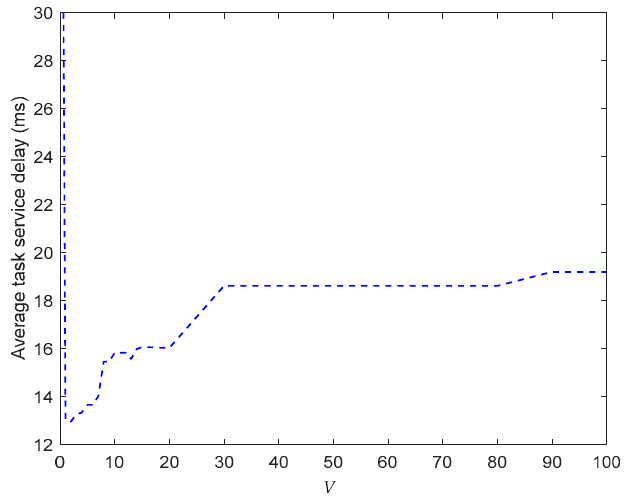
Figure 3. Average task service delay vs. V.